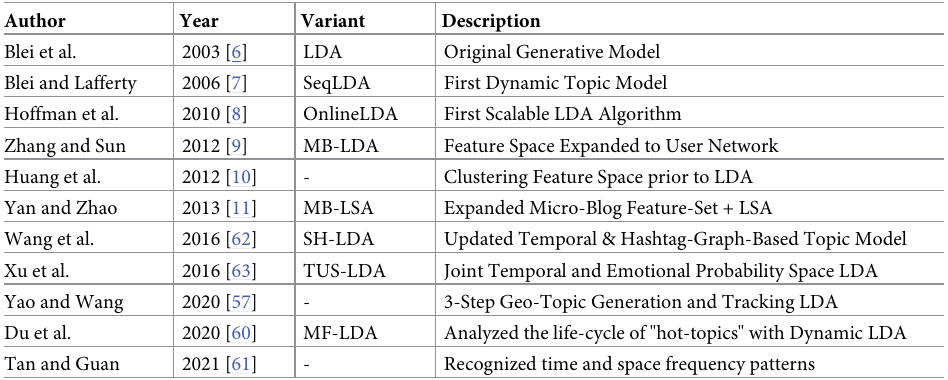
Table 1. Recent literature on topic modeling: LDA advancements and